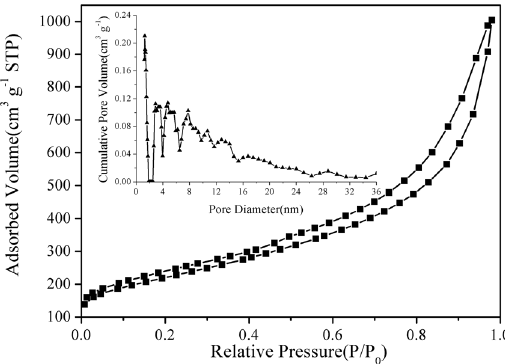
Figure 4. (Inset) pore size distribution and N 2 adsorption-desorption isotherms of Fe-Mt-SS-C.